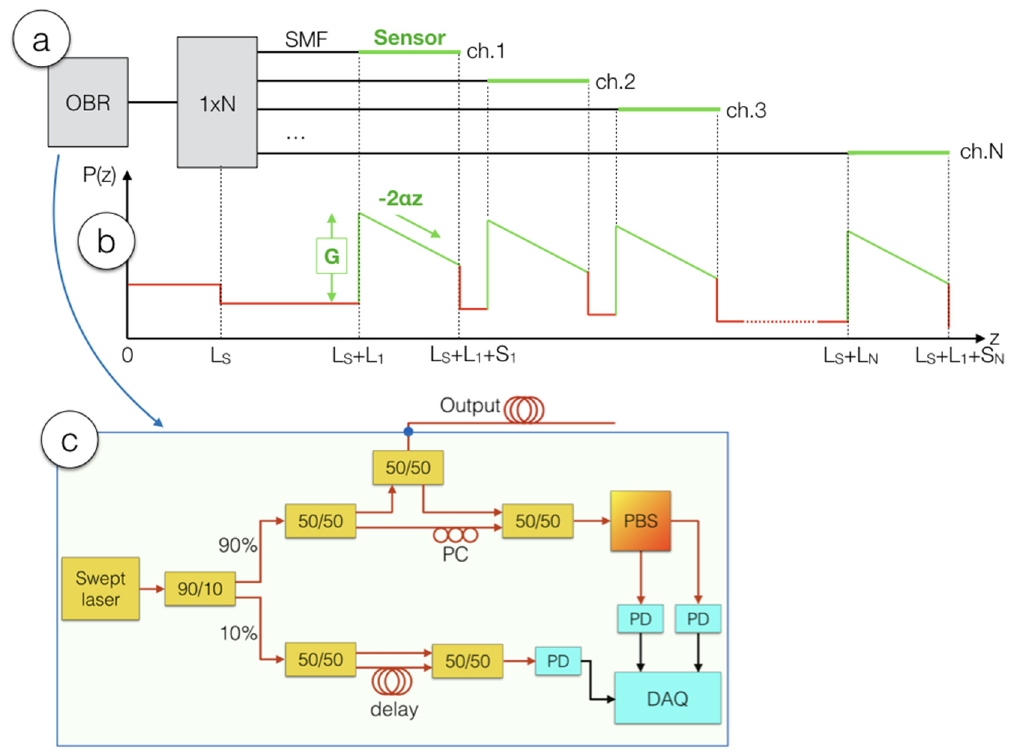
Figure 2. Principle of operation of the Scattering-Level Multiplexing (SLMux) setup. ( a ) Experimental setup implementing the SLMux, in the N-channel system; ( b ) power scattering trace, reporting the power P at each location z measured on the OBR in the SLMux setup; ( c ) detail of the swept-laser interferometer included in the OBR instrument (PD: photodetector, PBS: polarization beam splitter).